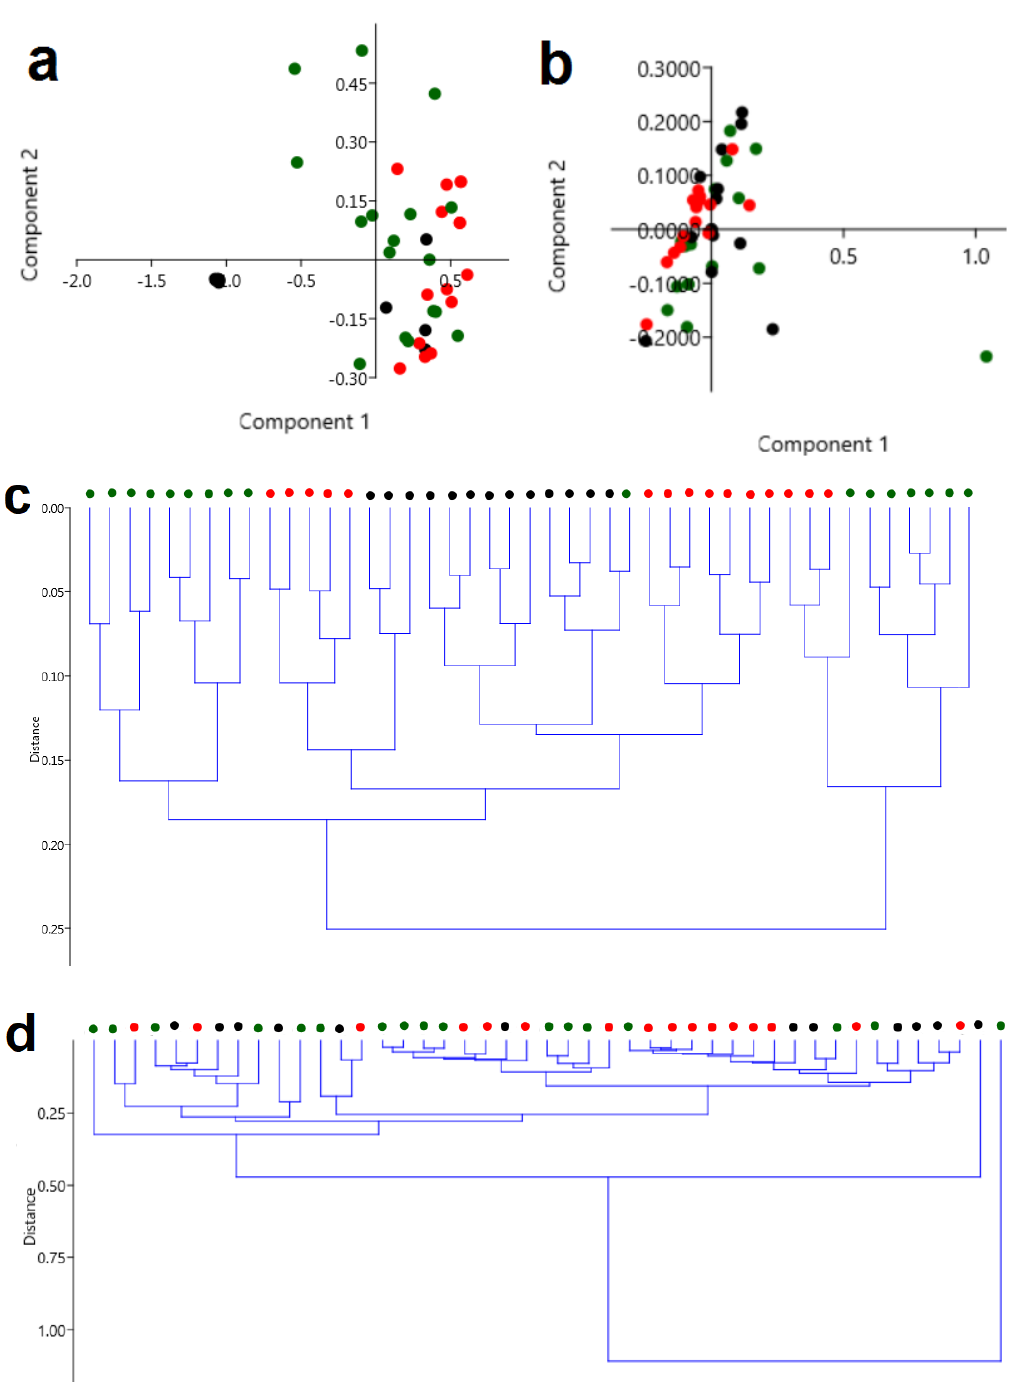
Figure 3. Principal component analysis (PCA) and hierarchical cluster analysis (HCA) analysis of Raman ( a , c ) and FTIR ( b , d ) spectra of control ( n = 17, green dot); atypical hyperplasia ( n = 12, black dot) and cancer ( n = 16, red dot) tissues. Two-dimensional (2D) scores plot of endometrium tissues samples, due to differences in chemical compositions presented through the Raman spectral regions between 800–1800 cm −1 .